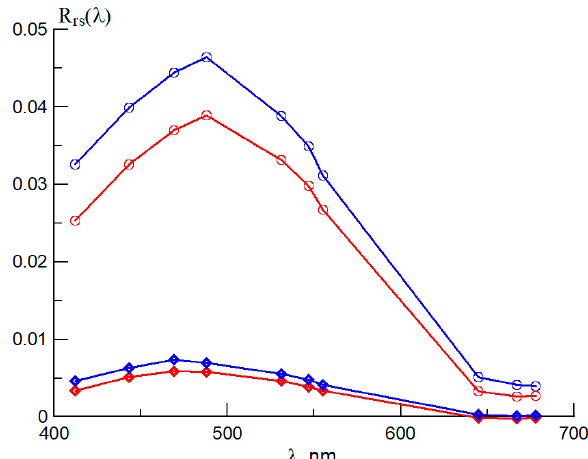
Figure 5. Spectral remote-sensing reflectance R rs ( λ ) from MODIS data measured over deep-water (blue lines) and shallow-water (red) stations in 2017 (circles) and 2018 (diamonds). The stations were located at depths of 50 and 1500 m in 2017 (June 8) and 2018 (June 9).